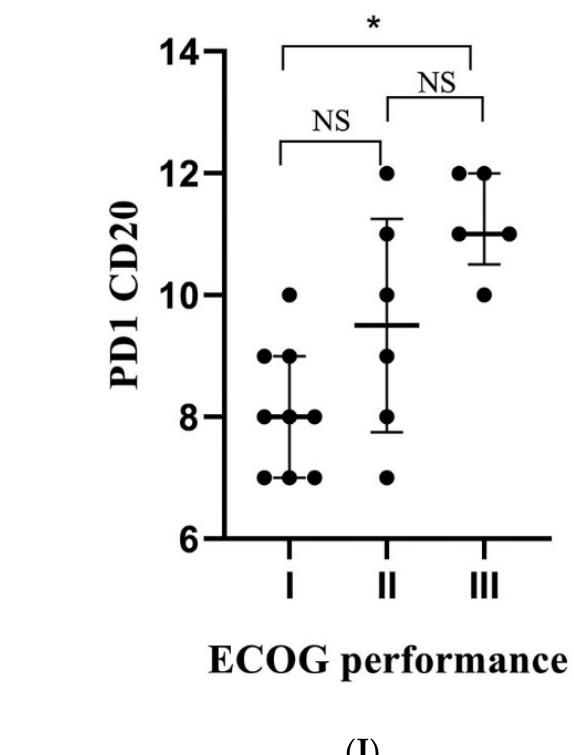
Figure 3. Percentage of PD-L1+CD20+ and PD-1+CD20+ in pre-therapy DLBCL patients with B symptoms ( A , B ); bone marrow involvement ( C , D ); DLBCL type ( E , F ); Ann Arbor stage ( G , H ) and ECOG performance ( I , J ). Each dot represented one patient. In total, 20 DLBCL patients were in- volved. NS: not significant; GCB: germinal center B-cell; ECOG: Eastern Cooperative Oncology Group; -ve: negative; +ve: positive. p -value is shown. * p < 0.05.